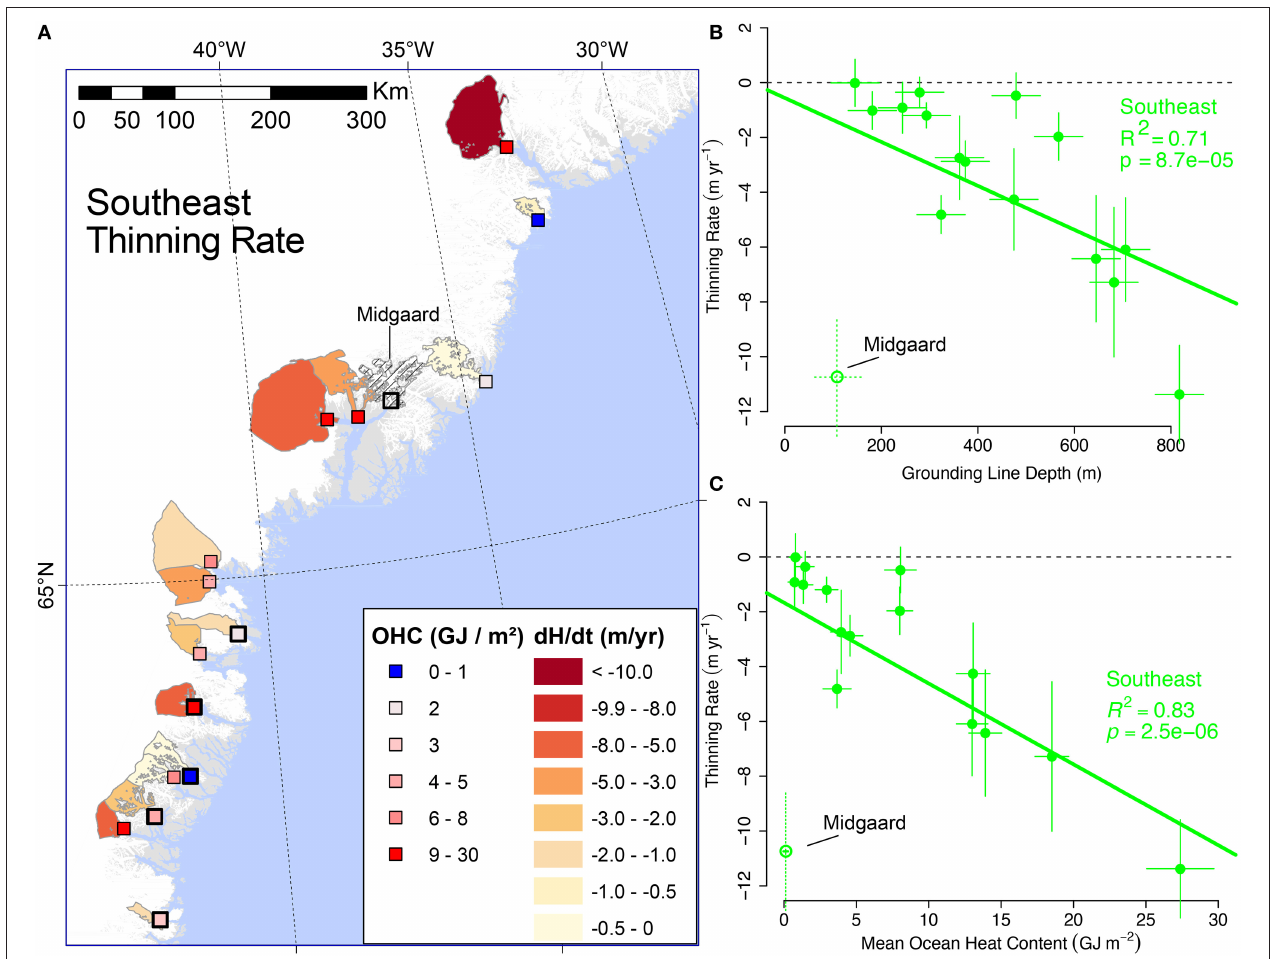
FIGURE 7 | As in Figure 5 : (A ) annual dynamic thinning rates ( m yr − 1 ) and modeled mean ocean heat content for the period 2003–2009, but instead for Southeast tidewater glaciers. (B) OLS regression of grounding line depth (m) with the maximum dynamic thinning rate for each catchment ( m yr − 1 ). Scatterplot shows Southeast glaciers as green points. Same for (C) except with ocean heat content (OHC) as the independent variable. The coefficient of determination is shown for Southeast